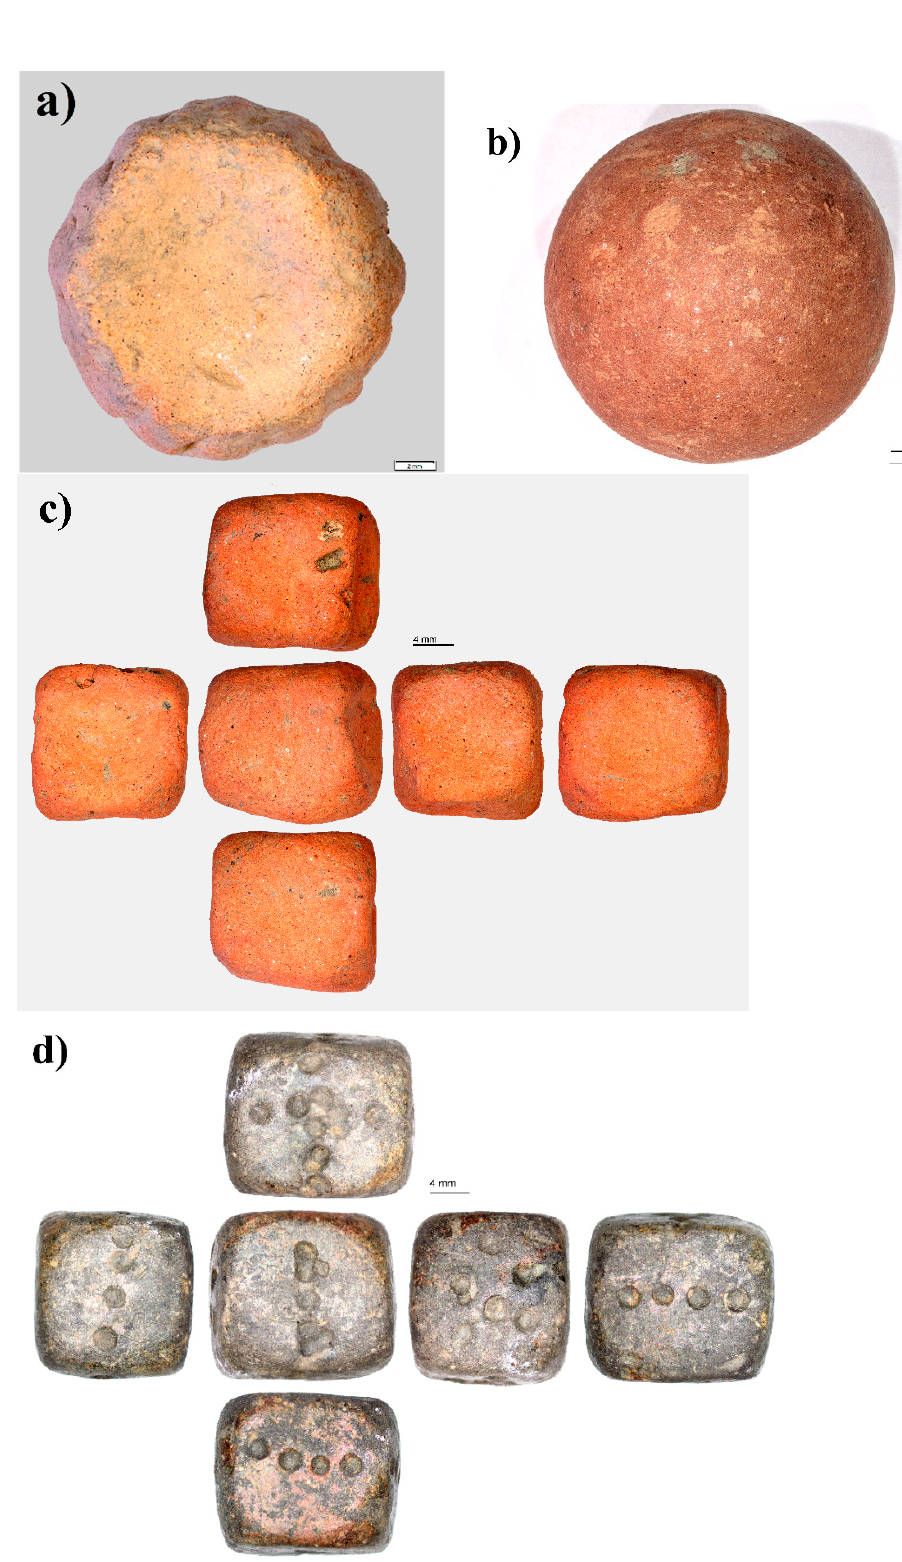
Figure 1. Representative shapes of the investigated objects from Villa del Foro: ( a ) washer-like disc, with indented borders (VF91.157/E1); ( b ) small ceramic sphere with a red colored surface (VFRS111); ( c ) cubic dice with no inscriptions and red-pigmented surface (VF14.SP384D); ( d ) cubic dice with numbers or other signs (VF90.1549/E32). The scale bars are ( a , b ) 2 mm, and ( c , d ) 4 mm.